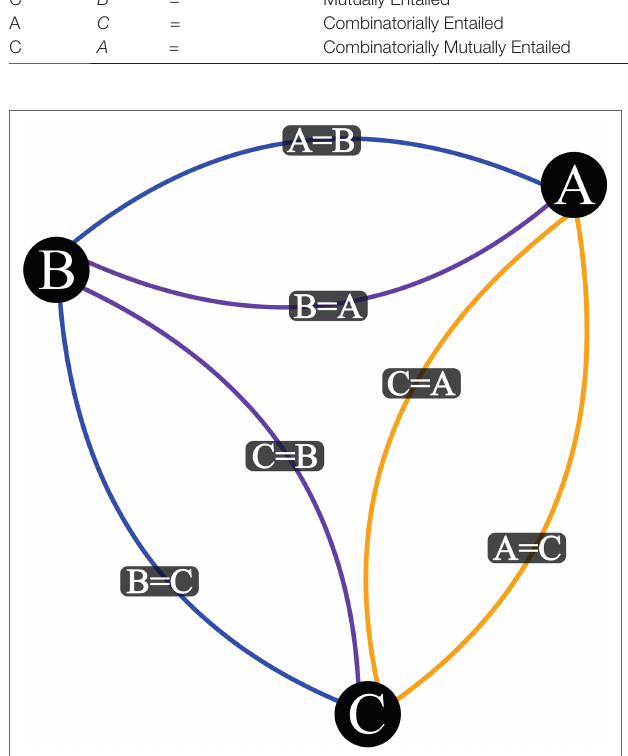
FIGURE 1 | Visualization Output for three Stimulus Equivalence Network with a Base Relational Set of A = B and B = C . Vertex represent stimuli, blue edges are input relations, purple edges are mutually derived relations, and orange edges are combinatorially derived